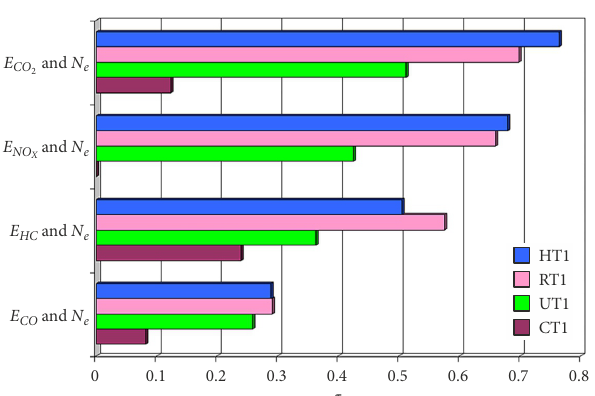
Figure 18. Coefficient of Kendall’s tau correlation t between the pollutant emission intensity ( E CO , E NO , E CH , E CO ) , E NO , E CH , E CO ) 2 2 X X and the non-negative effective power N e in individual tests (CT1, UT1, RT1,